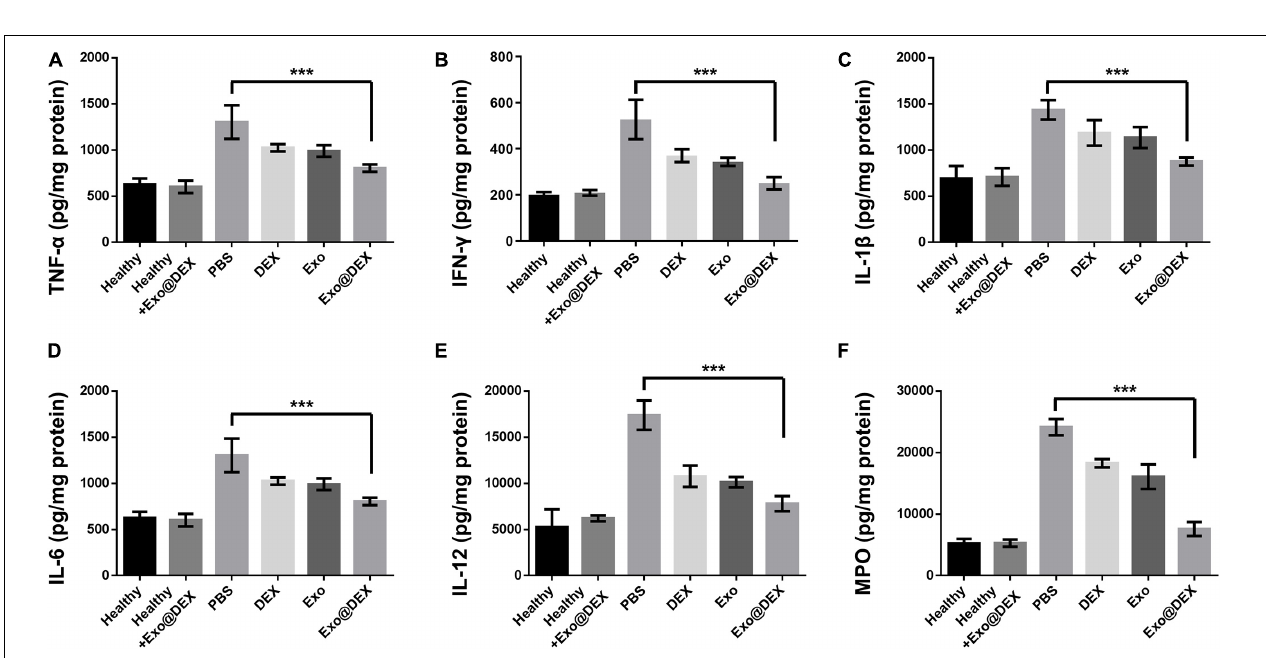
FIGURE 5 | Detection of cytokines in liver tissues. Cytokines of TNF- α (A) , INF- γ (B) , IL-1 β (C) , IL-6 (D) , IL-12 (E) , and MPO (F) were measured in liver homogenates form each group ( n = 5 for each group). Data are presented as the mean ± SD and were assessed via one-way ANOVA (*** P < 0.001).